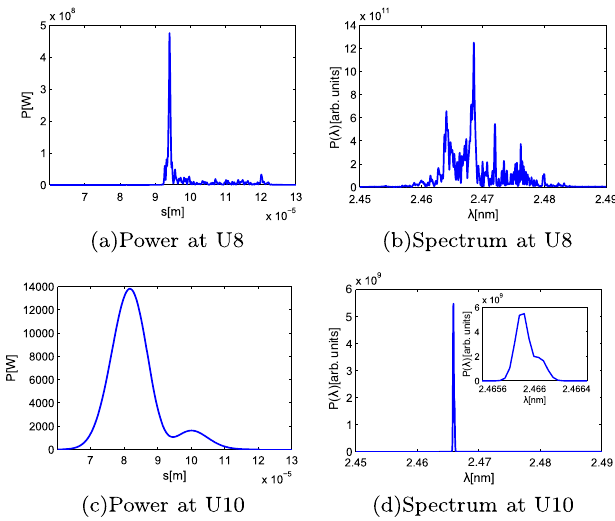
FIG. 13. 500 eV FEL pulse at the end of the SASE undulator in time domain (a) was transformed to frequency domain (b). Spectrum was filtered (d) after being multiplied by the mono- chromator instrumental function (Fig. 15). Afterwards it was transformed back to time domain (c), representing effective power distribution at the entrance of the seeded undulator.